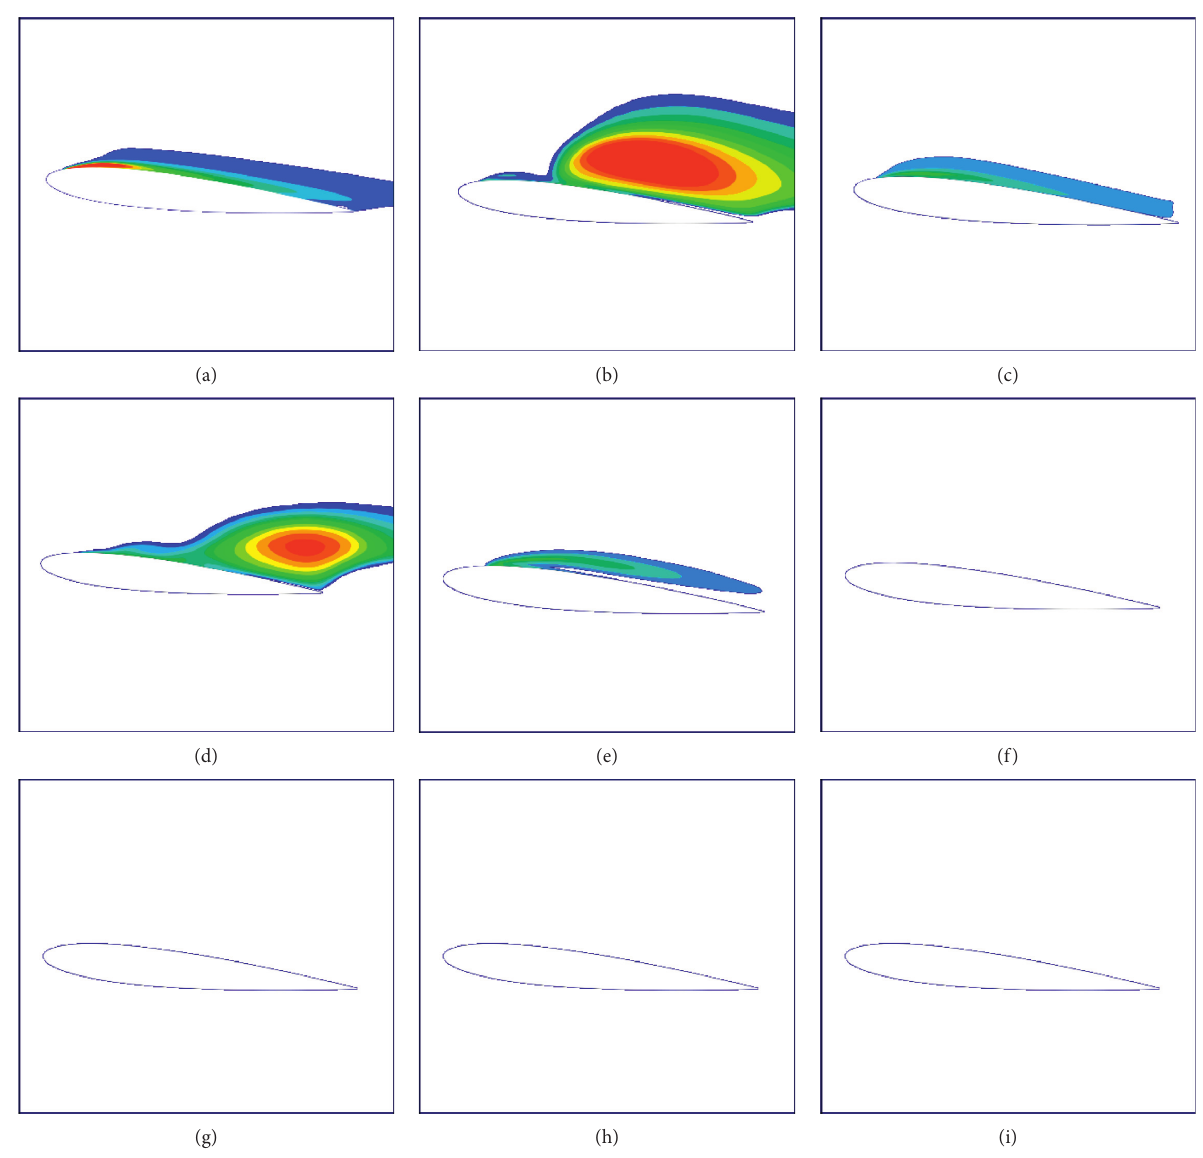
Figure 4: Cavitation nephogram of NACA hydrofoil. (a) 5 ∼ 2 cavitation nephogram. (b) 5 ∼ 4 cavitation nephogram. (c) 5 ∼ 6 cavitation nephogram. (d) 10 ∼ 2 cavitation nephogram. (e) 10 ∼ 4 cavitation nephogram. (f) 15 ∼ 2 cavitation nephogram. (g) 15 ∼ 4 cavitation nephogram. (h) 20 ∼ 2 cavitation nephogram. (i) 20 ∼ 4 cavitation